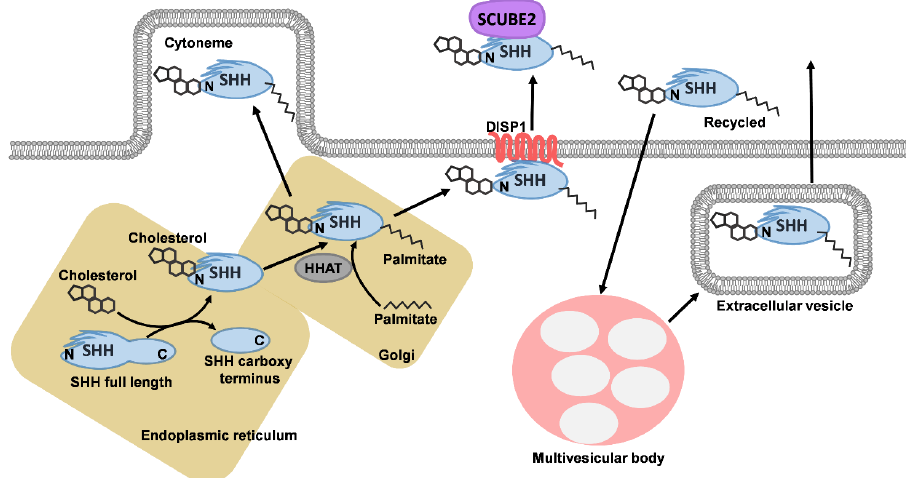
Figure 1. SHH production and secretion. SHH polypeptides are transported to the endoplasmic reticulum and golgi, where they are cleaved into the amino-terminal domain (which has signalling function) and carboxyl-terminal domain (autoprocessing regulation). The amino-terminal part is modified with palmitate (mediated by HHAT) and cholesterol (mediated by carboxyl end of the initial polypeptide). The active part of SHH may be transported to a cytoneme or bound to DISP1. SHH that has already been secreted can be recycled into the cell, transported to microvesicular bodies where they can be packaged into extracellular vesicles for secretion (modified after